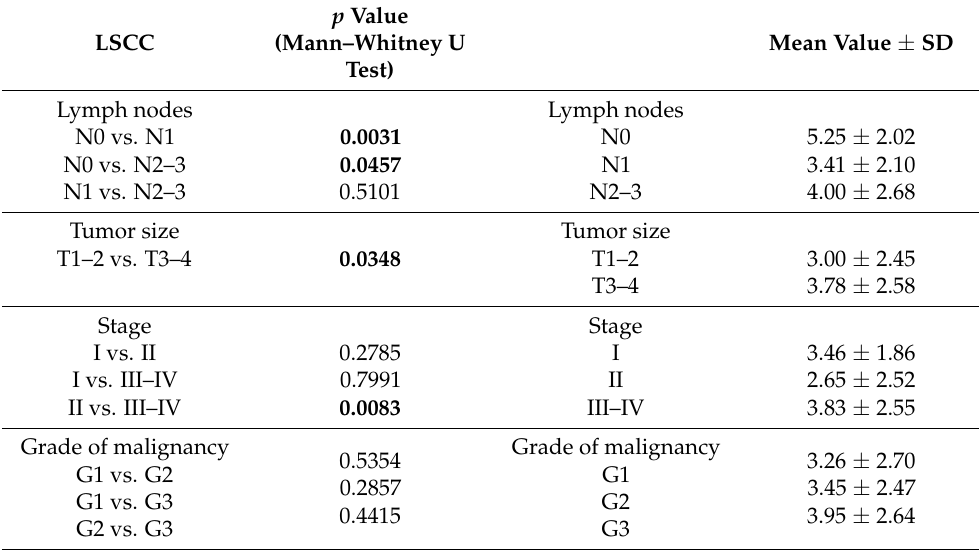
Table 3. Associations of irisin expression level with clinicopathological characteristics in patients with LSCC.